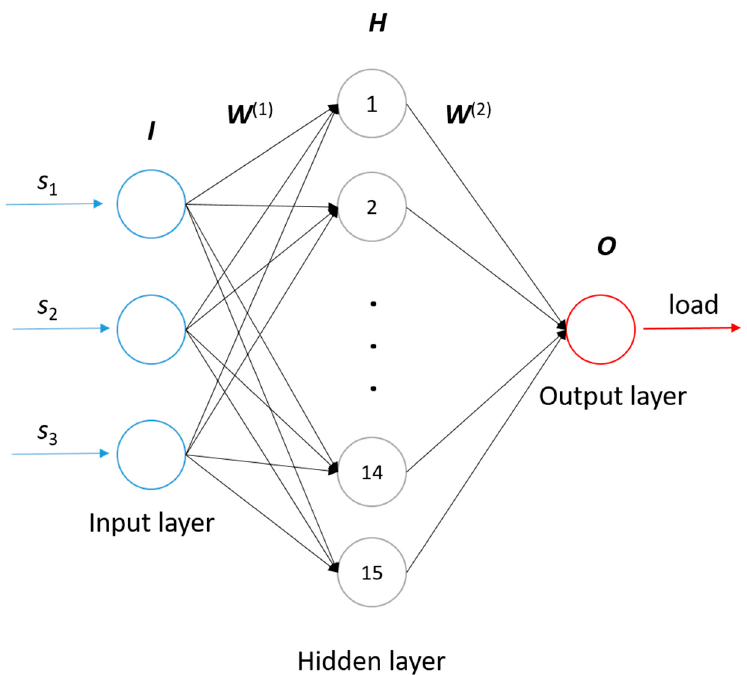
Figure 10. The employed back-propagation neural network (BPNN) model to predict loads.